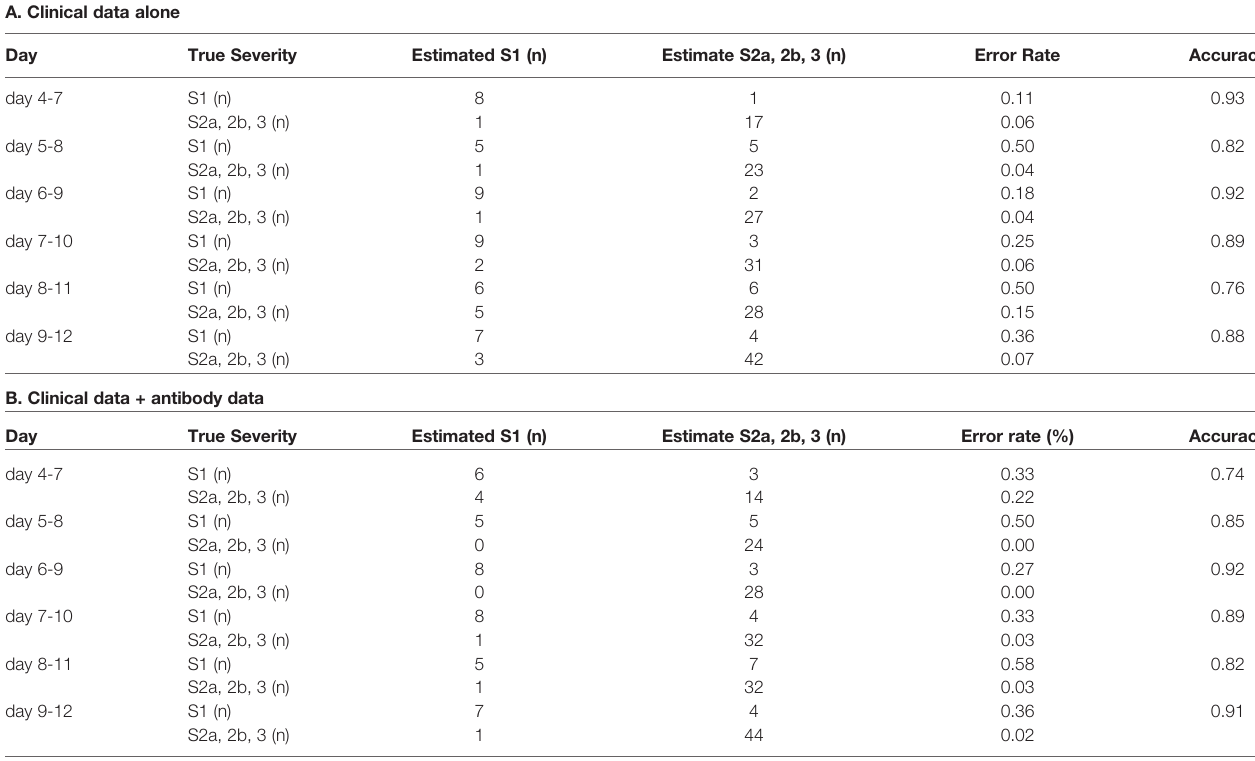
TABLE 1 | The accuracy of the model to distinguish severity group 2a or over from severity group 1 in the validation